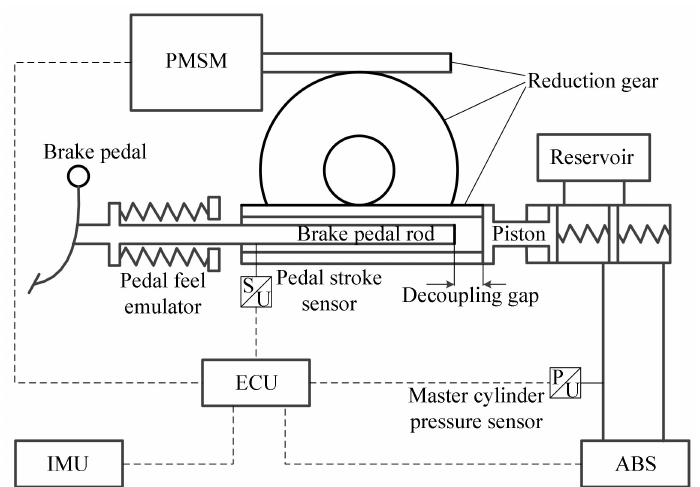
Figure 4. Scheme of the electro-hydraulic brake system